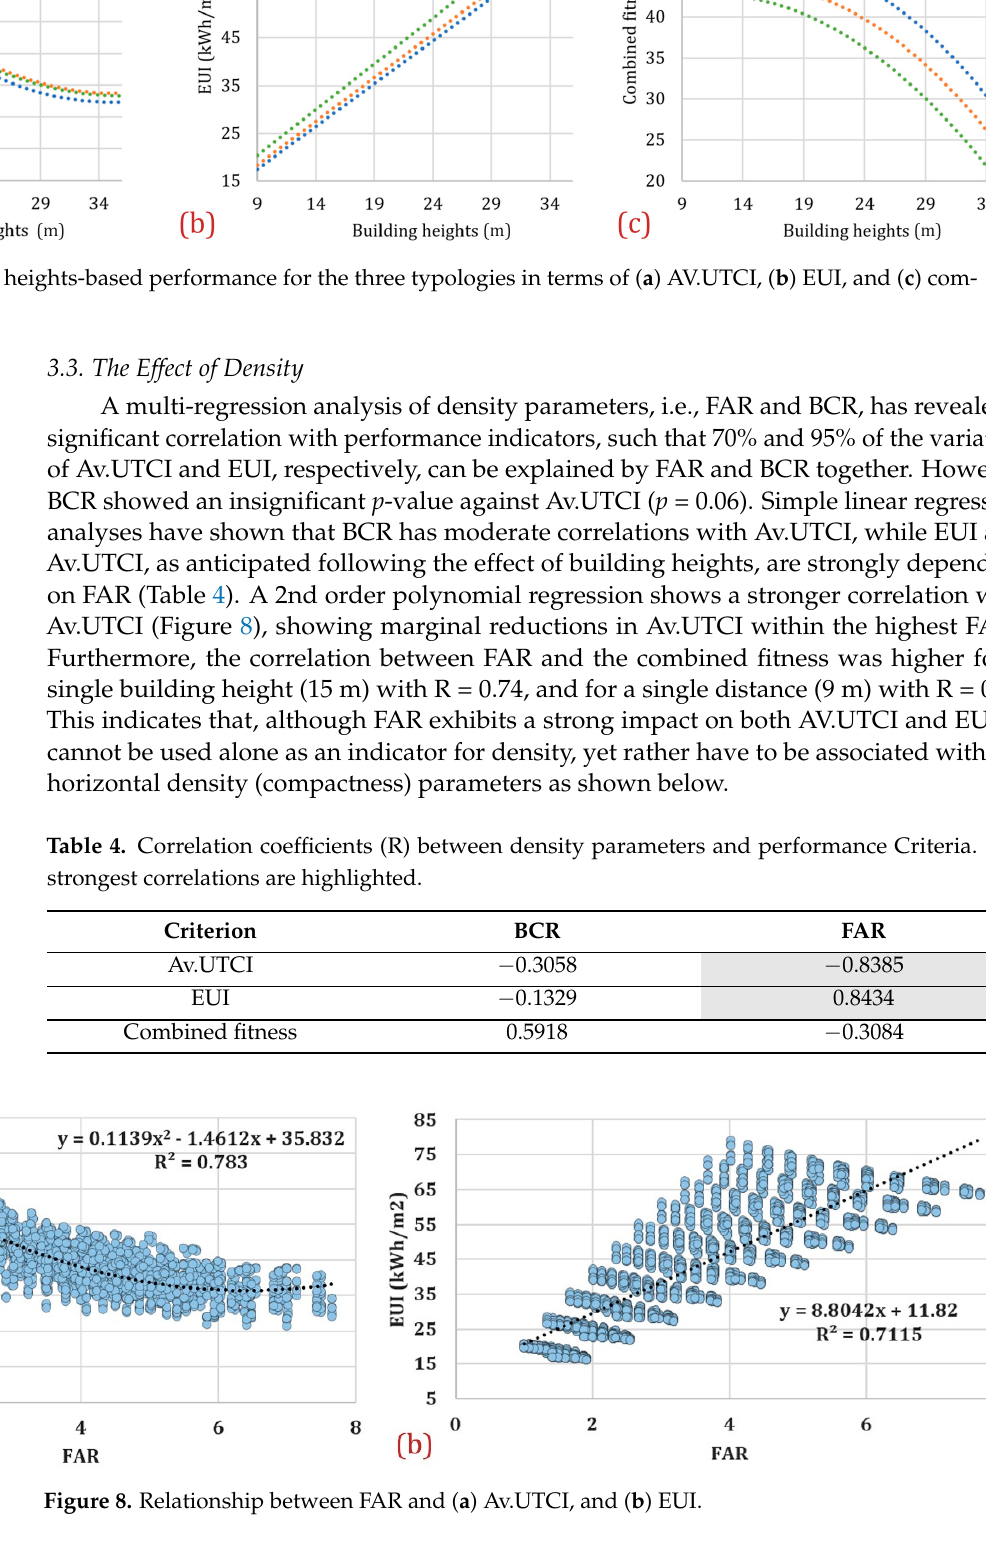
14 of 23 Figure 6. Distances between buildings/blocks on the East–West axis across different orientations (shown as deviation from starting position) plotted against the performance indicators, ( a ) AV.UTCI, ( b ) EUI, and ( c ) combined fitness. A single EW distance comprises the average of all other North–South distances. 3.2.3. Building Heights Buildings’ heights are shown to have the strongest correlation with thermal and en- ergy performance. Figure 7 shows the trendlines indicating the variations in performance as building heights change. The effect of changing building heights appears to be more significant than changing the typology. In Figure 7a, As building heights increase, Av.UTCI decreases by 2.5 °C, due to improved shading, thereby improving thermal com- fort. The relationship, however, between the Av.UTCI and building heights is polynomial, and so is the relationship with FAR as discussed in the next section, indicating a near- constant Av.UTCI above a certain height (33 m in this study), after which the streets be- come fully shaded and do not benefit from any further increase in building heights. Dif- ferences between typologies seem to be negligible, showing the courtyards slightly lower in Av.UTCI. Conversely, taller buildings with larger floor spaces resulted in higher EUIs, increasing by as much as 50 kWh/m 2 (Figure 7b). The impact of changing the heights is more significant on EUI than on Av.UTCI, and so are the variations between typologies. This is well explained by the linear relationship between EUI and the building heights.